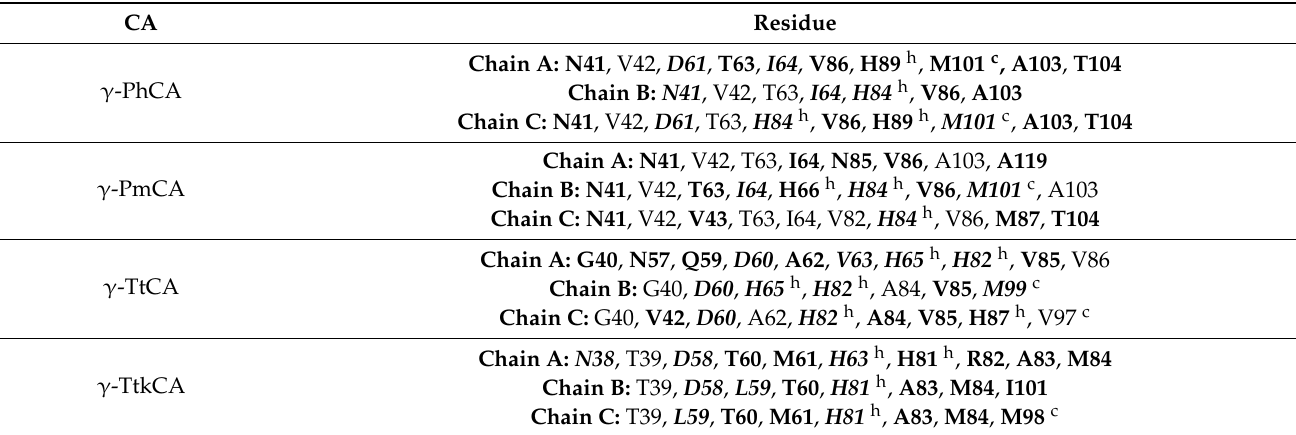
Figure 6. ( A ): Heat maps of root mean square fluctuation (RMSF) ( top ) and average BC ( bottom ) of residues from I —γ -PhCA, II —γ -PmCA, III —γ -TtCA and IV- γ -TtkCA. ( B ): Structures of I —γ -PhCA, II —γ -PmCA, III —γ -TtCA and IV —γ -TtkCA. Hotspot residues (green), top 5% average BC residues (blue) and an intersection of the two (purple) are mapped as spheres. Regions fluctuating above 0.4 nm at 423 K were colored red. Zn 2+ metal ions are depicted as grey spheres. Table 3. Top 5% average betweenness centrality ( BC ) residues. Interface residues are in bold text and hotspot residues are bold and